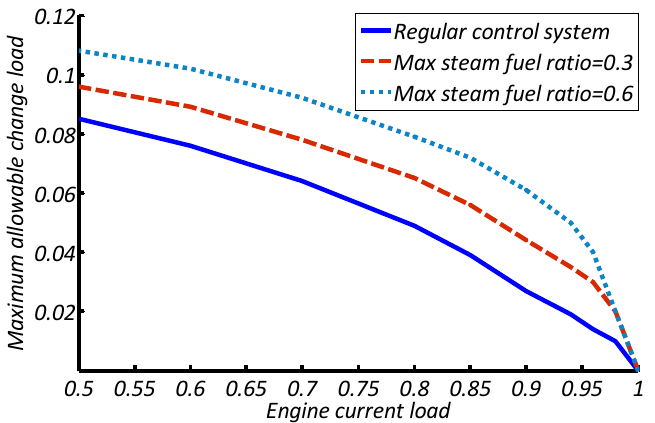
Figure 7. Maximum allowable change load in different load for the proposed control algorithm vs. the regular control algorithm when the gas turbine is running in island